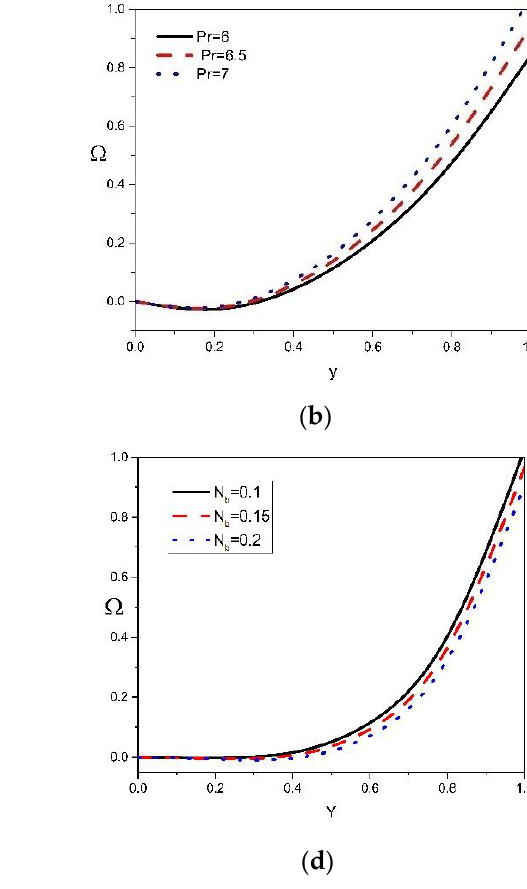
Figure 4. ( a – d ) Concentration distribution versus Y for various physical parameter